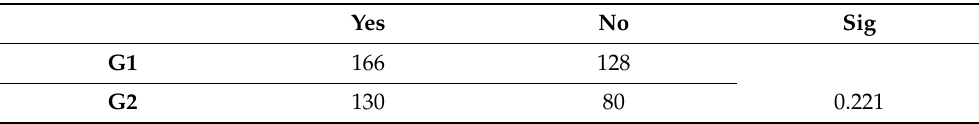
Table 4. The number of owners that consistently fed a particular brand of complementary feed/cereal- containing mixed feed.